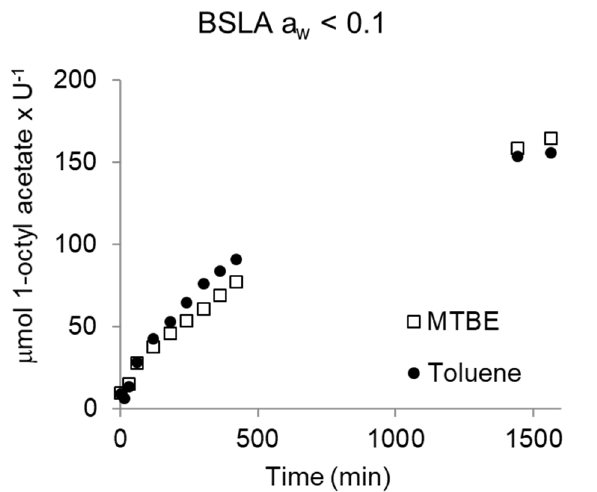
Figure 8. Activity of BSLA, in MTBE and toluene a w < 0.1. Reaction conditions: 0.5–1.2 U of catalyst, 100 mM 1-octanol, 500 mM vinyl acetate, 500 mM decane (ISTD), in dry solvent (1 mL reaction) at 30 ◦ C and 1000 rpm. U: µ mol butyric acid × min − 1 . Blanks were performed in the absence of enzyme and showed no conversion.